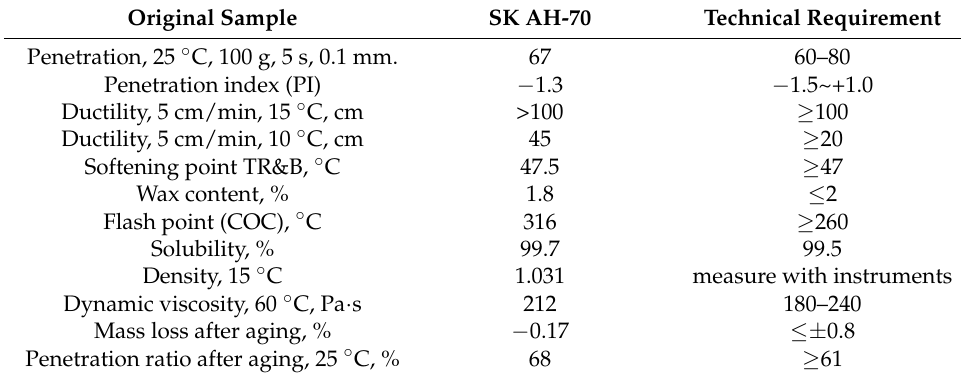
Table 2. Material properties of 70#1.